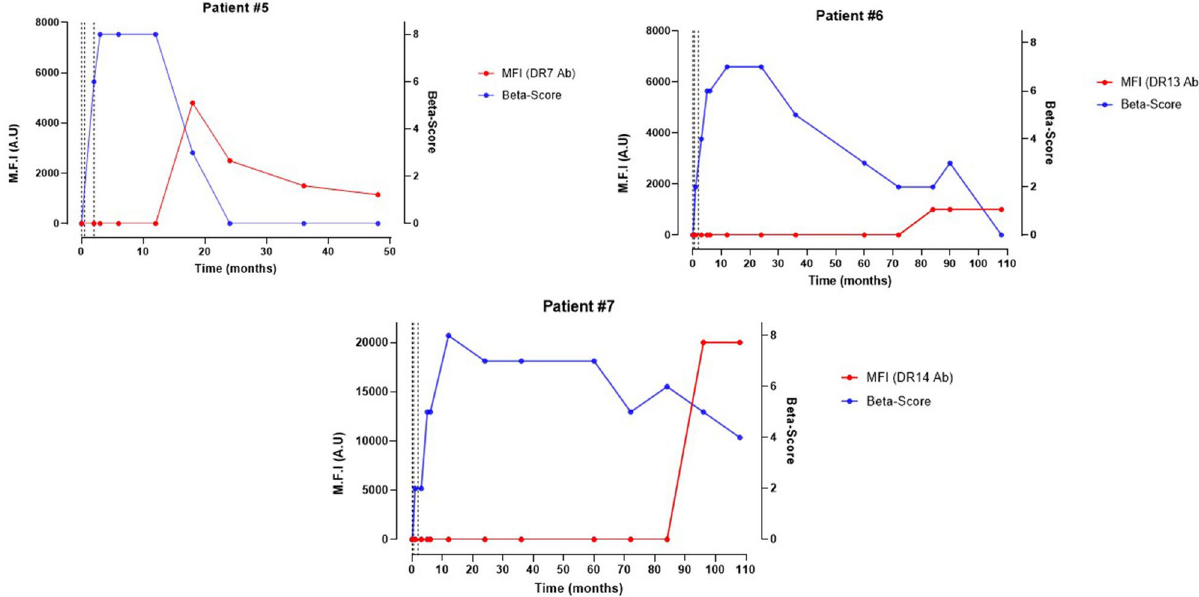
Figure 5. Evolution of β-Score over time in type 1 diabetic pancreatic islet recipients presenting with late de novo Donor Specific Antibodies. Patient#5 (top left panel), Patient#6 (top right panel) and Patient#7 (bottom panel) presented with late de novo DSA at 17 months, 77 and 99 months, respectively. Vertical dash lines represent every pancreatic islet injection. Ab Antibody; MFI Mean-Fluorescence